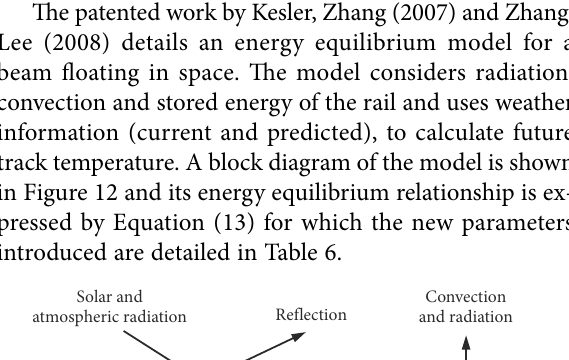
Convection and radiationReflection